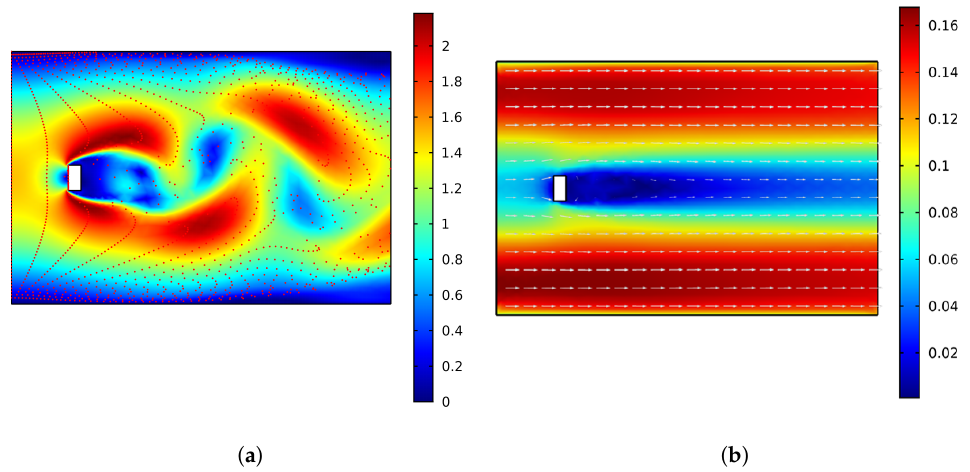
Figure 2. Comparative finite element analysis of laminar and turbulent flows: ( a ) model built with laminar flow interface where R e ≈ 50; velocity magnitude in m/s—red points present particle tracing with mass; drag-driven particle movement; ( b ) model built with turbulent flow k − (cid:101) interface where R e ≈ 5 × 10 5 ; velocity field in m/s—arrows represent the fluid flow